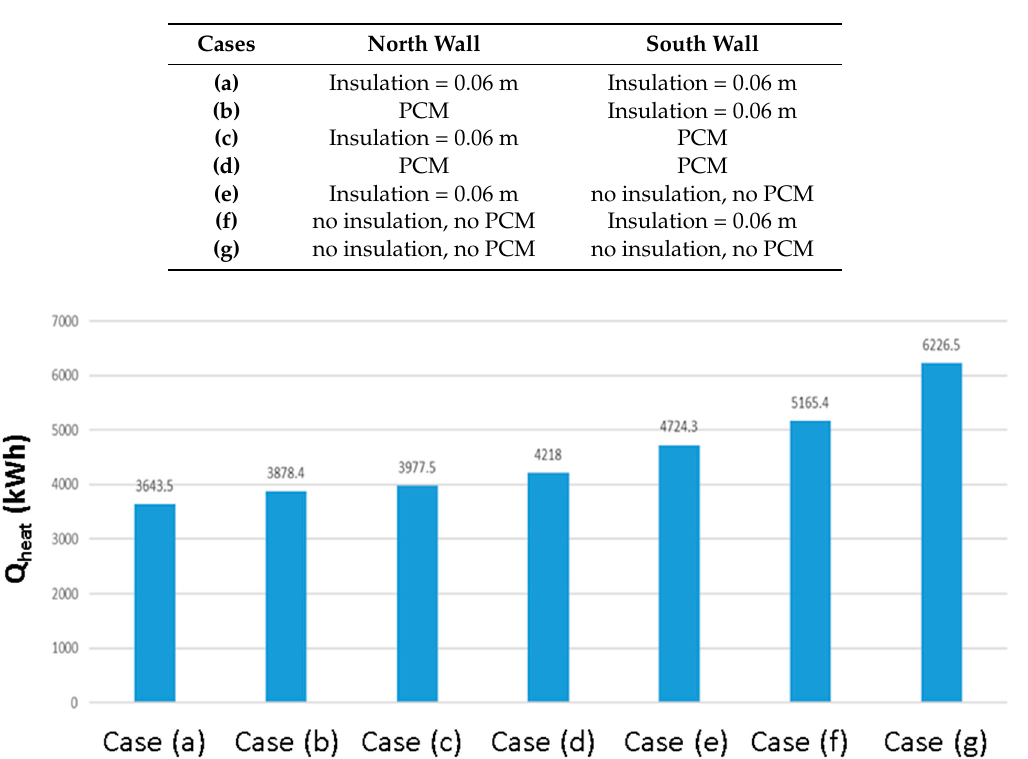
Table 4. Different cases in south and north walls.